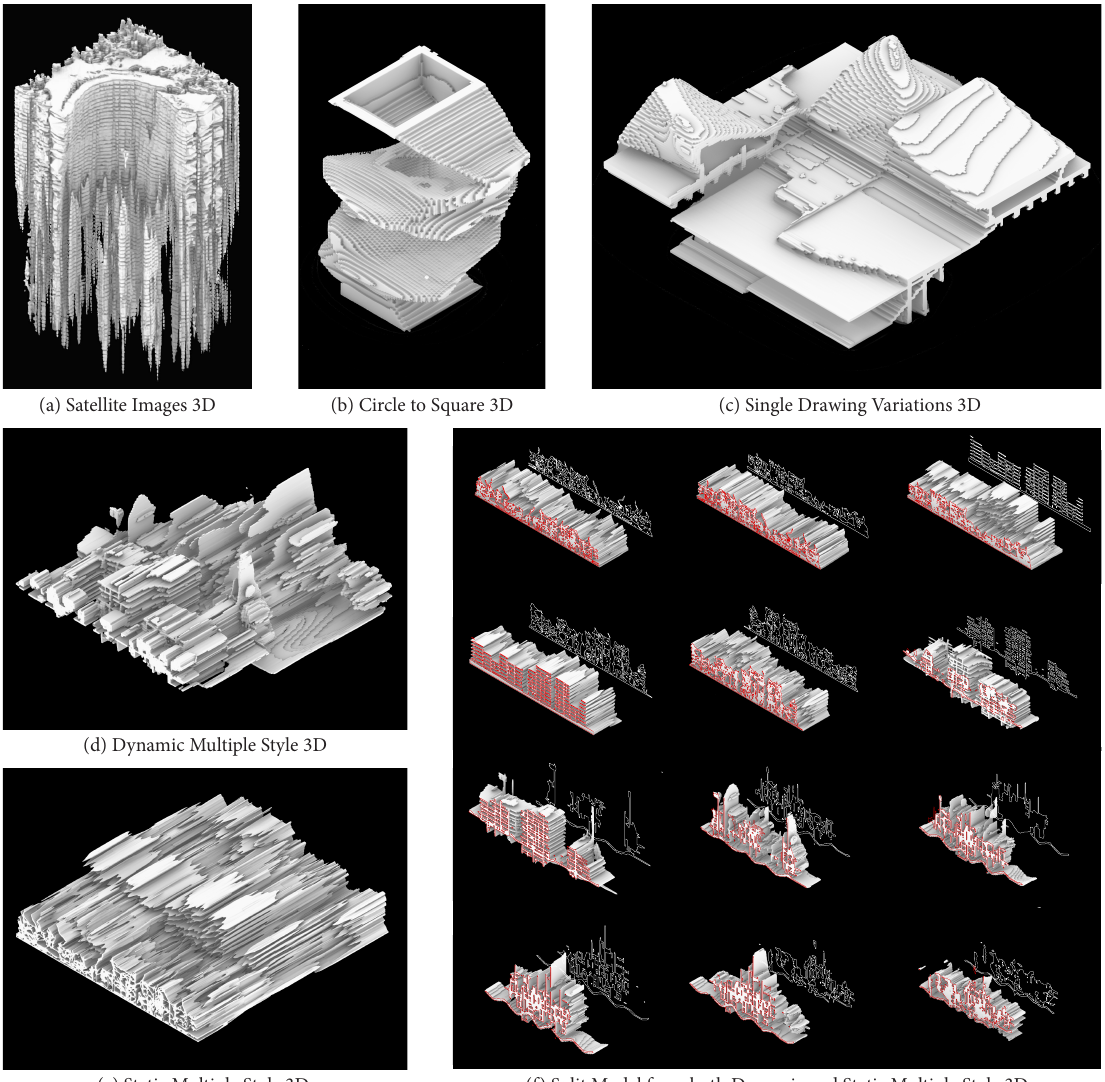
Figure 11. These are the 3D models generated from truncation trick images of previous training results: ( a ) 3D model generated from satellite images training. ( b ) 3D model generated from circle to square training. ( c ) 3D model generated from single drawing variations training. ( d ) 3D model generated from dynamic multiple-style training. ( e ) 3D model generated from static multiple-style training. ( f ) Split 3D model from both dynamic and static multiple-style training (the red line represents the section at the front and the white line represents the section at the